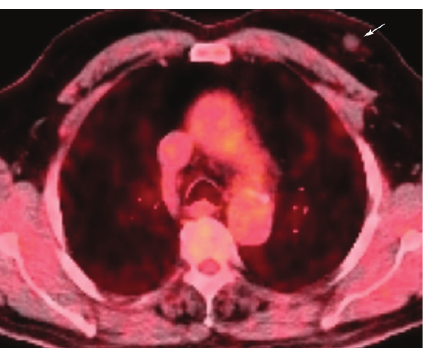
Figure 3: Axial 18-fluorine deoxyglucose positron emission tomography (18F-FDG-PET)/computed tomography (CT) fusion images and PET/CT fusion sections showing focal minimal FDG uptake in left breast.